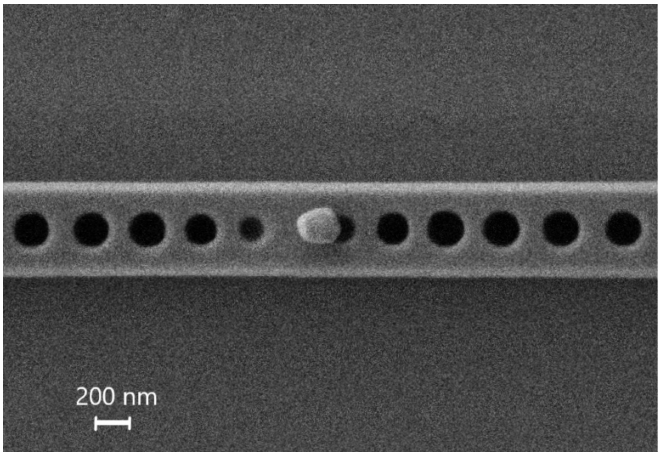
Figure 5. The result of the transfer of a BTO particle to a Si waveguide on a glass